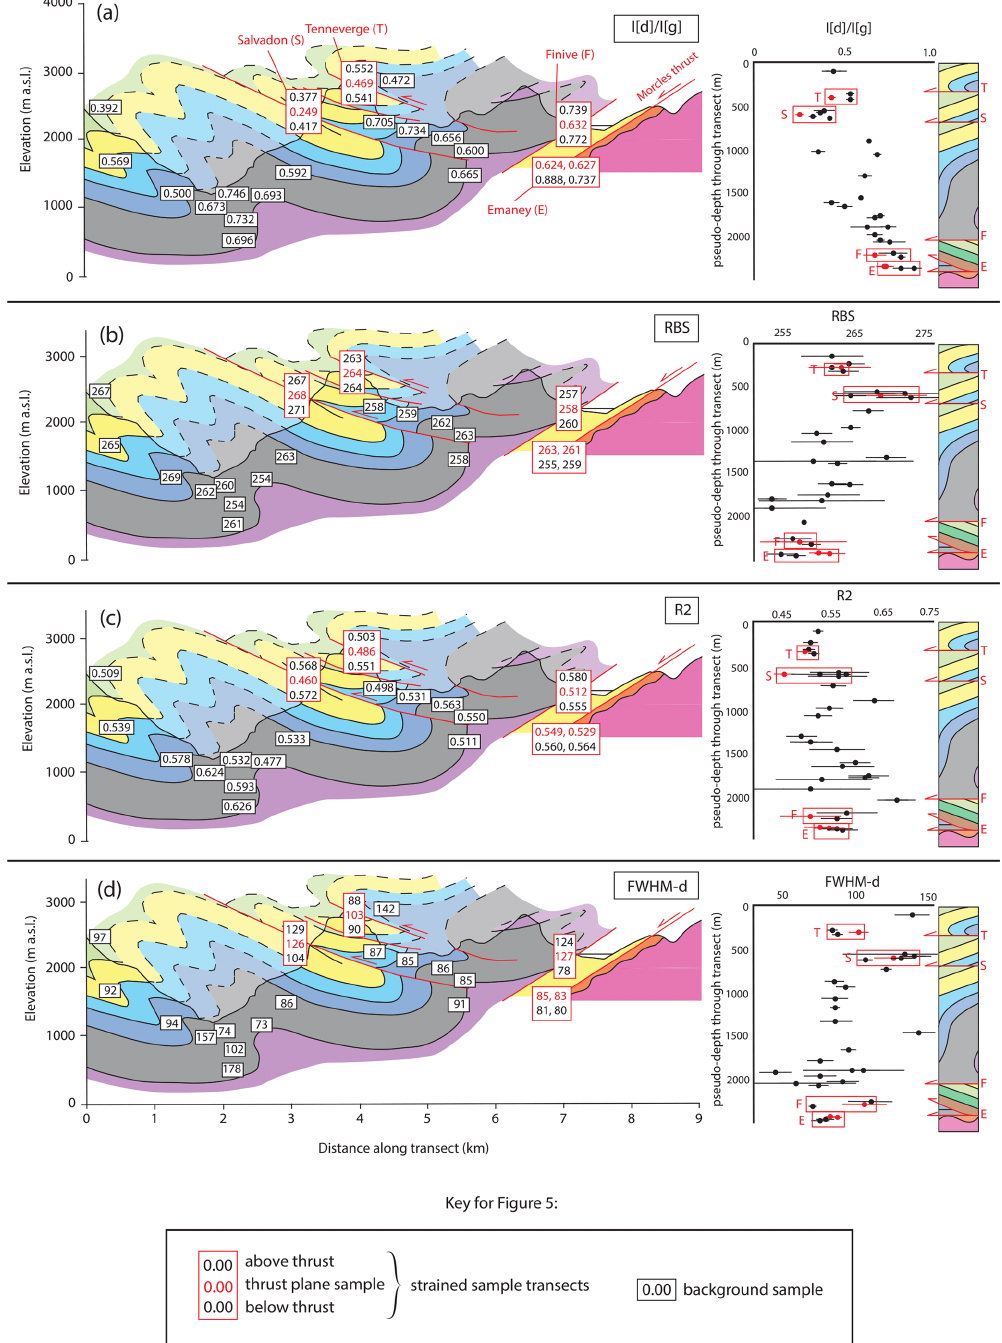
Figure 5. Cross-sections and depth transects showing values of (a) I D / I G , (b) Raman band separation, (c) area ratio R 2 , and (d) D-peak width. Labelled values on cross-sections indicate the approximate position of samples, with numbers in black boxes representing “back- ground” samples and those in red boxes indicating samples through “strained” localities. Within strained localities, red numbers represent fault plane or shear zone samples. The depth transects on the right of each panel are accompanied by a simplified stratigraphic column for reference. Strained localities are highlighted by red boxes labelled with a corresponding letter (T: Tenneverge, S: Salvadon, F: Finive, E: Emaney), with the thrust plane or shear zone sample indicated by a red dot. Horizontal lines on transects are error bars (standard deviation for all spectra and deconvolutions for that